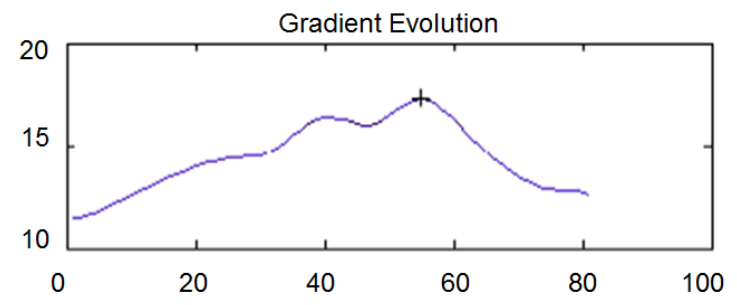
Figure 6. Evolution of the gradient along a